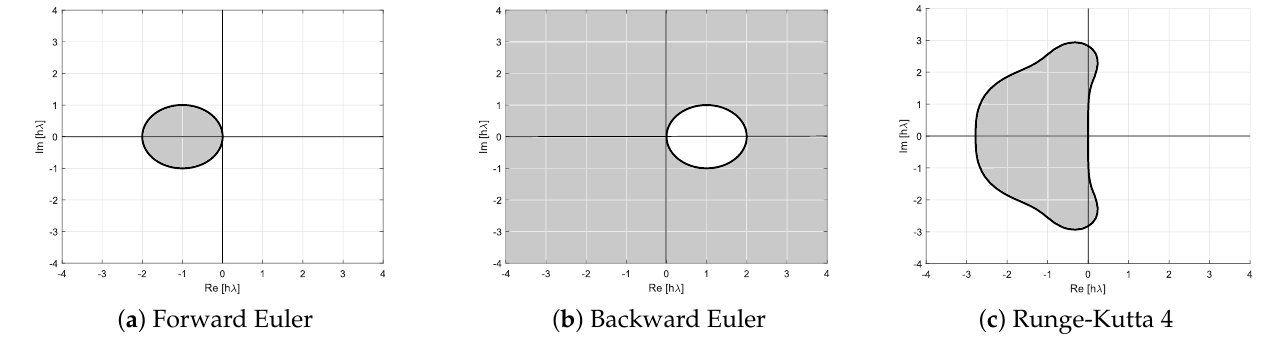
Figure 5. Stability regions of one-step methods listed in Table 1.